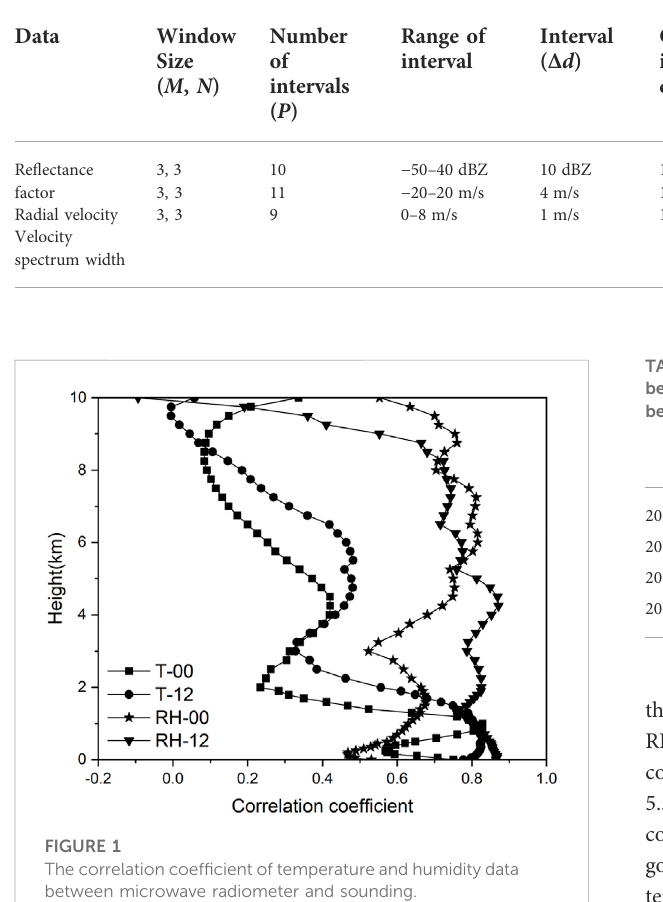
TABLE 2 Optimal values of parameters and thresholds for the “ K-domain frequency count ” method.